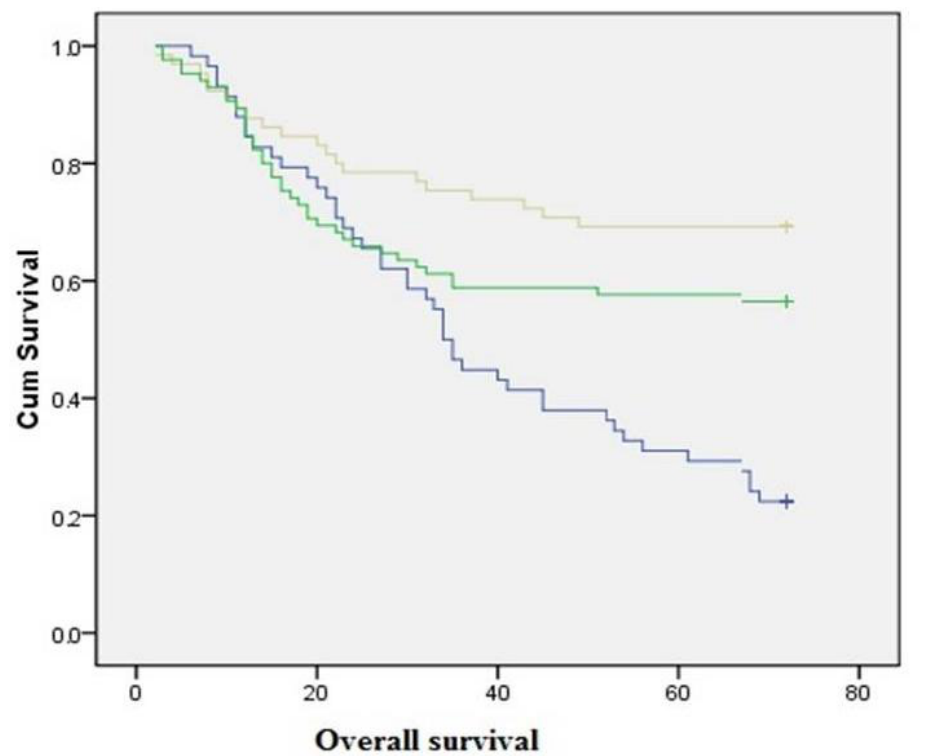
Figure 2. Overall ovarian cancer survival by folate intake level.